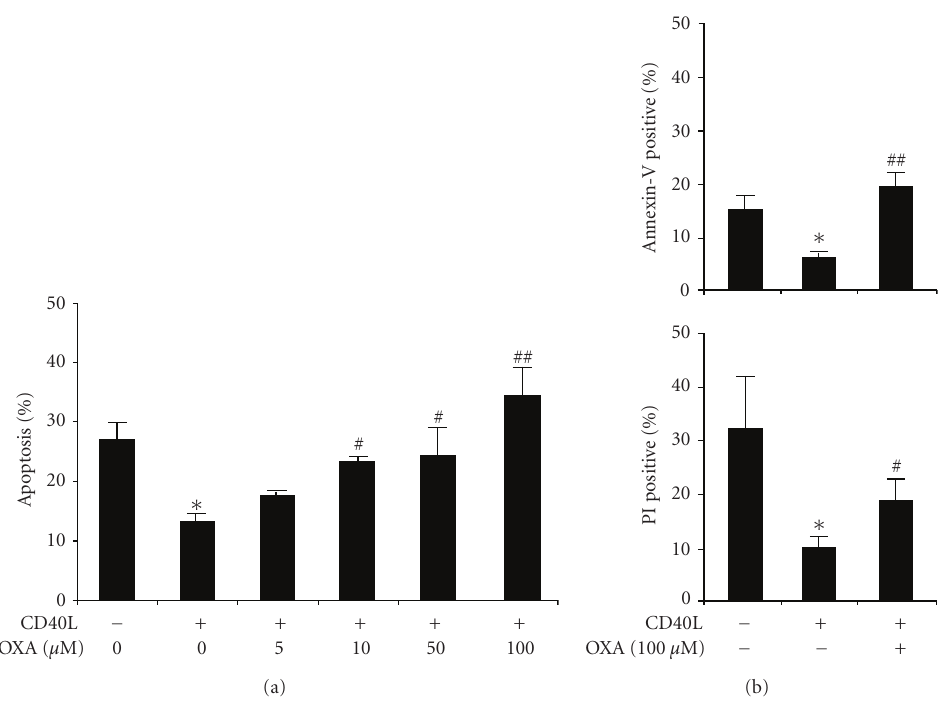
Figure 1: Oxaprozin increases apoptosis in CD40L-treated monocytes . Monocytes were incubated for 48 hours with control medium or 200ng/mL CD40L plus 1 μ g/mL CD40L enhancer in the presence or absence of di ff erent doses (0, 5, 10, 50, 100 μ M) of oxaprozin. (a) Assessment of apoptosis by acridine-orange-stained slides under fluorescence microscopy. Data are express as percentages of apoptotic cells on total number of cells counted (mean ± SEM, n = 3; apoptosis in absence versus in presence of CD40L: ∗ P < .05; apoptosis in presence of CD40L versus CD40L plus 10 or 50 μ M oxaprozin: # P < .05; apoptosis in presence of CD40L versus CD40L plus 100 μ M oxaprozin: ## P < .01). (b) Assessment of apoptosis by using Annexin V and Propidium Iodide (PI) binding assay. (mean ± SEM, n = 4; apoptosis in absence